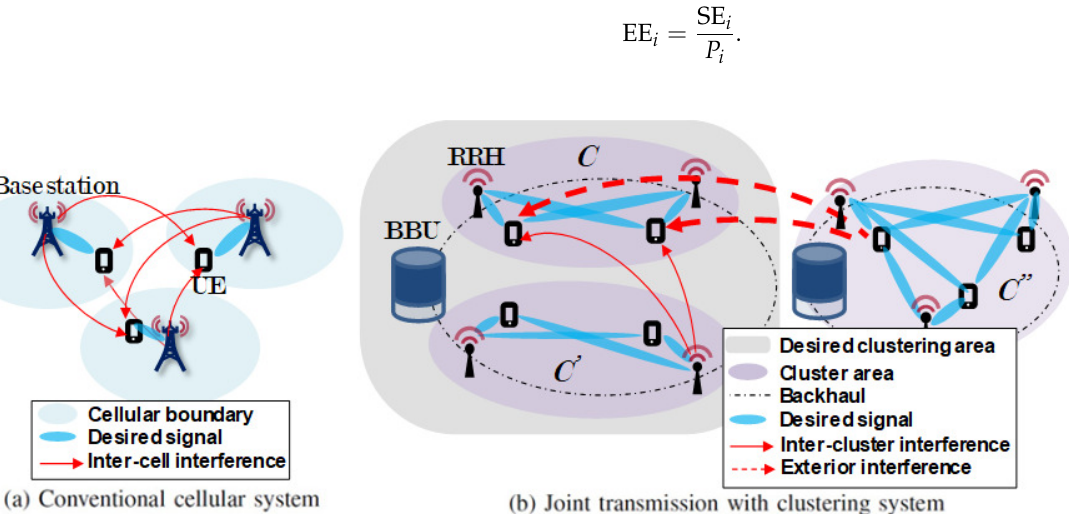
Figure 2. Concept of conventional cellular and joint transmission a with clustering system. ( a ): conventional cellular system; ( b ): joint transmission with clustering